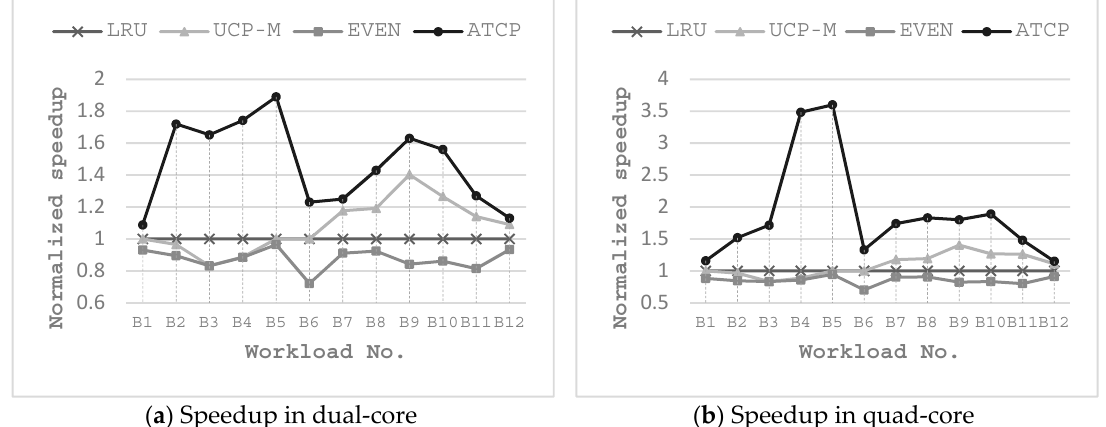
Figure 13. Normalized speedup of various cache partitioning schemes. ( a ) Speedup in dual-core, ( b ) Speedup in quad-core.